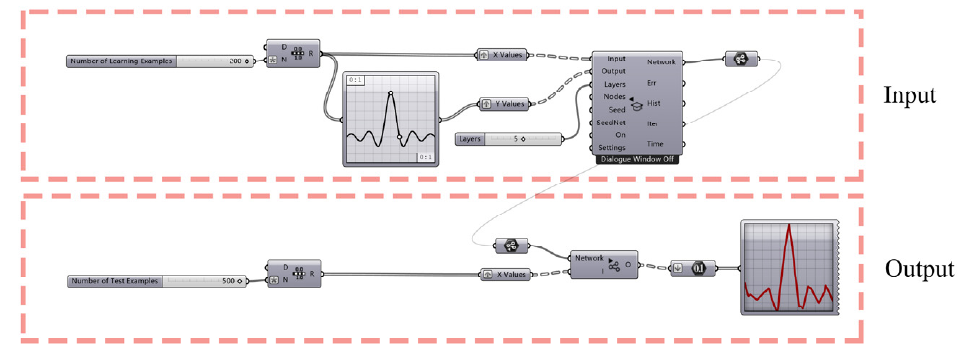
Figure 5. ANN battery pack.